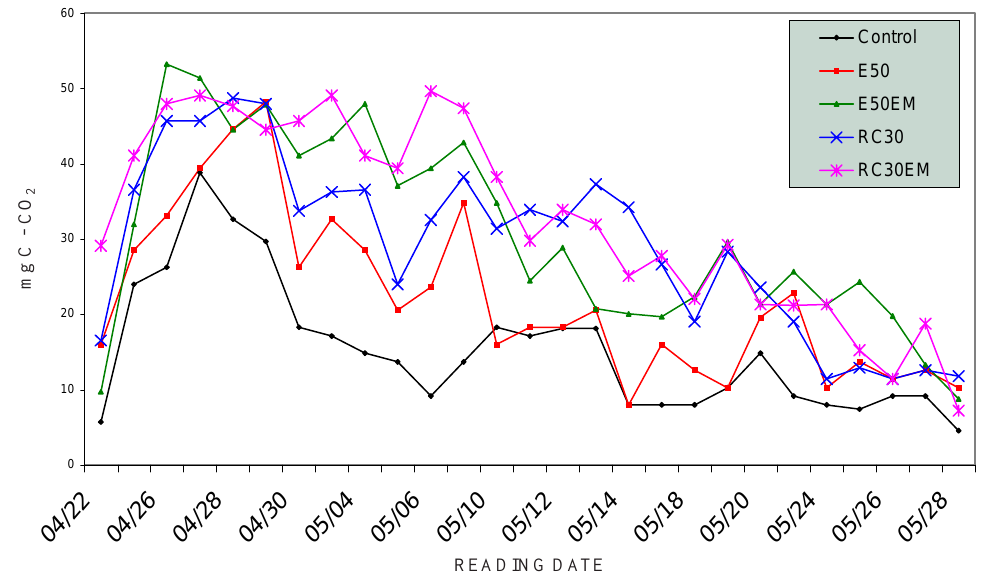
Figure 1. Determination of total microbial activity (mg CO different kinds of organic matter and incubated at 25